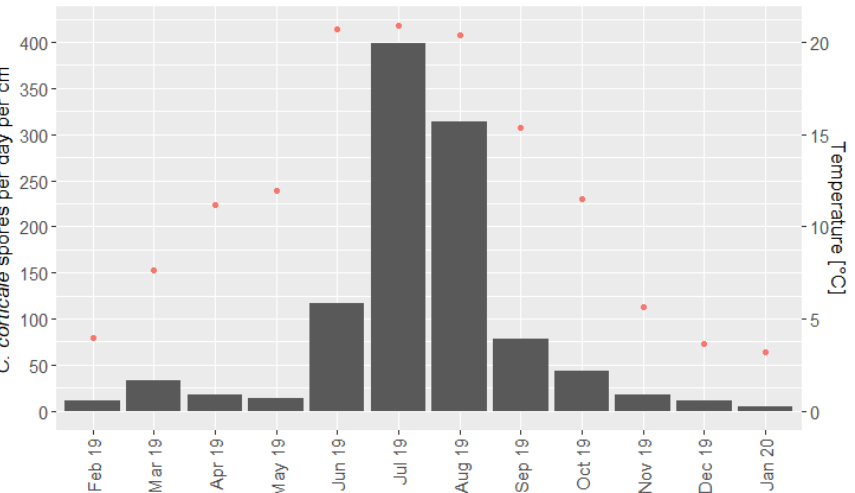
Figure 3. Seasonal abundance of spores of C. corticale per day per cm 2 (grey columns) from February 2019 to January 2020 in spore traps in the forest site close to Wuerzburg, Germany; n = 2 – 3; right y-axis: mean monthly temperatures 2019 in the weather station Wuerzburg (red dots) of the German Meteorological Service.